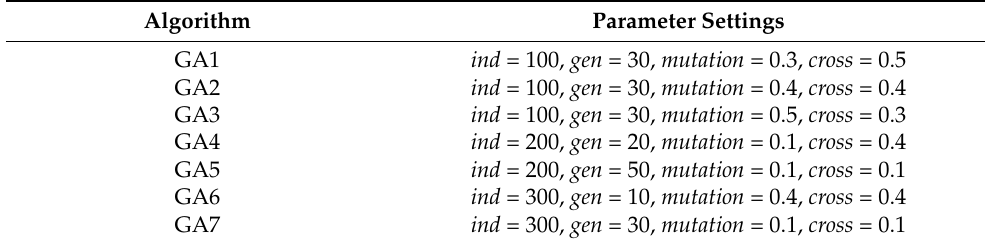
Table 3. The parameter settings for GA and